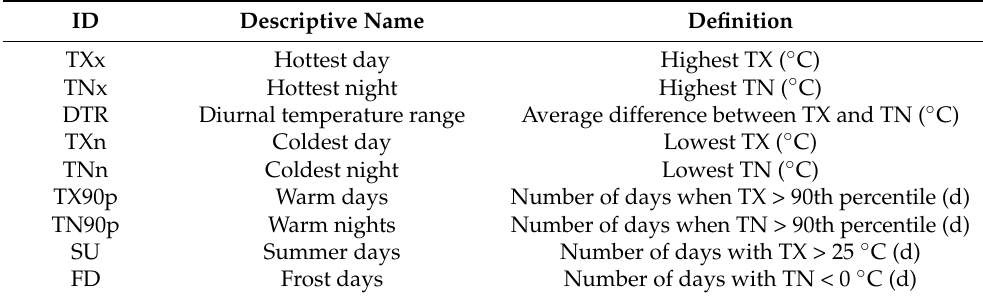
Table 2. Name and interpretation of the nine extreme temperature